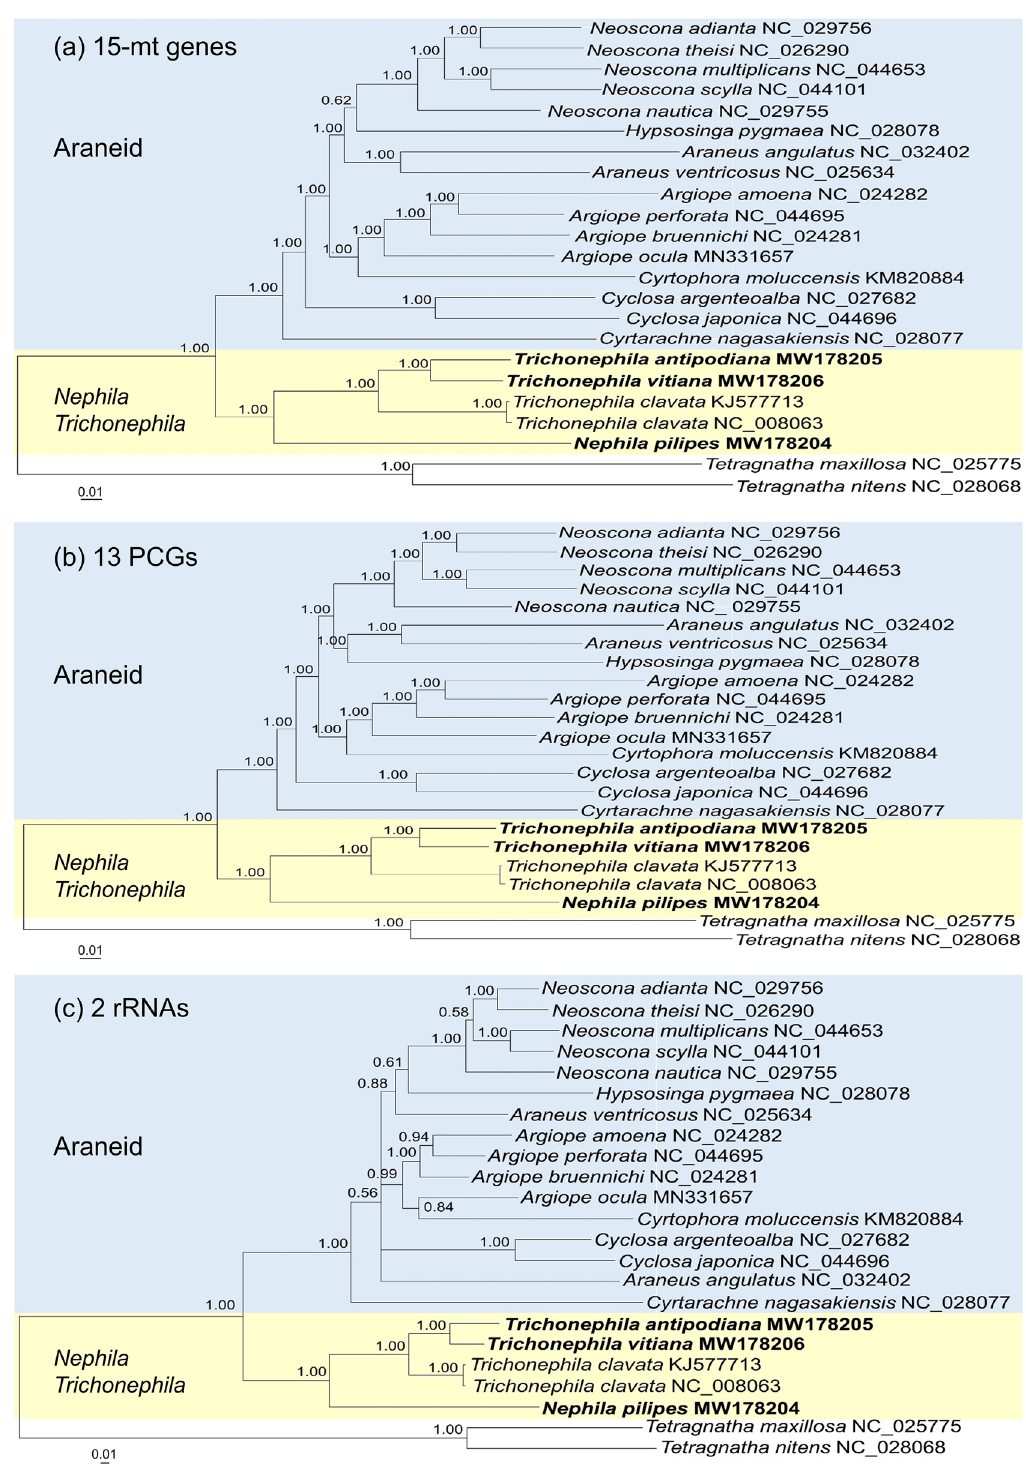
Figure 6. Bayesian inference phylogenetic tree based on ( a ) 13 PCGs and 2 rRNA genes, ( b ) 13 protein-coding genes, and ( c ) 2 rRNA genes of the whole mitogenomes of Nephila , Trichonephila and other araneid taxa with Tetragnatha taxa as outgroup. Trichonephila vitiana (previously Nephila vitiana ); Numeric values at the nodes are Bayesian posterior probabilities. Figures generated by Mr Bayes v.3.1.2 (https:// nbisw eden. github. io/ MrBay es/ downl oad.